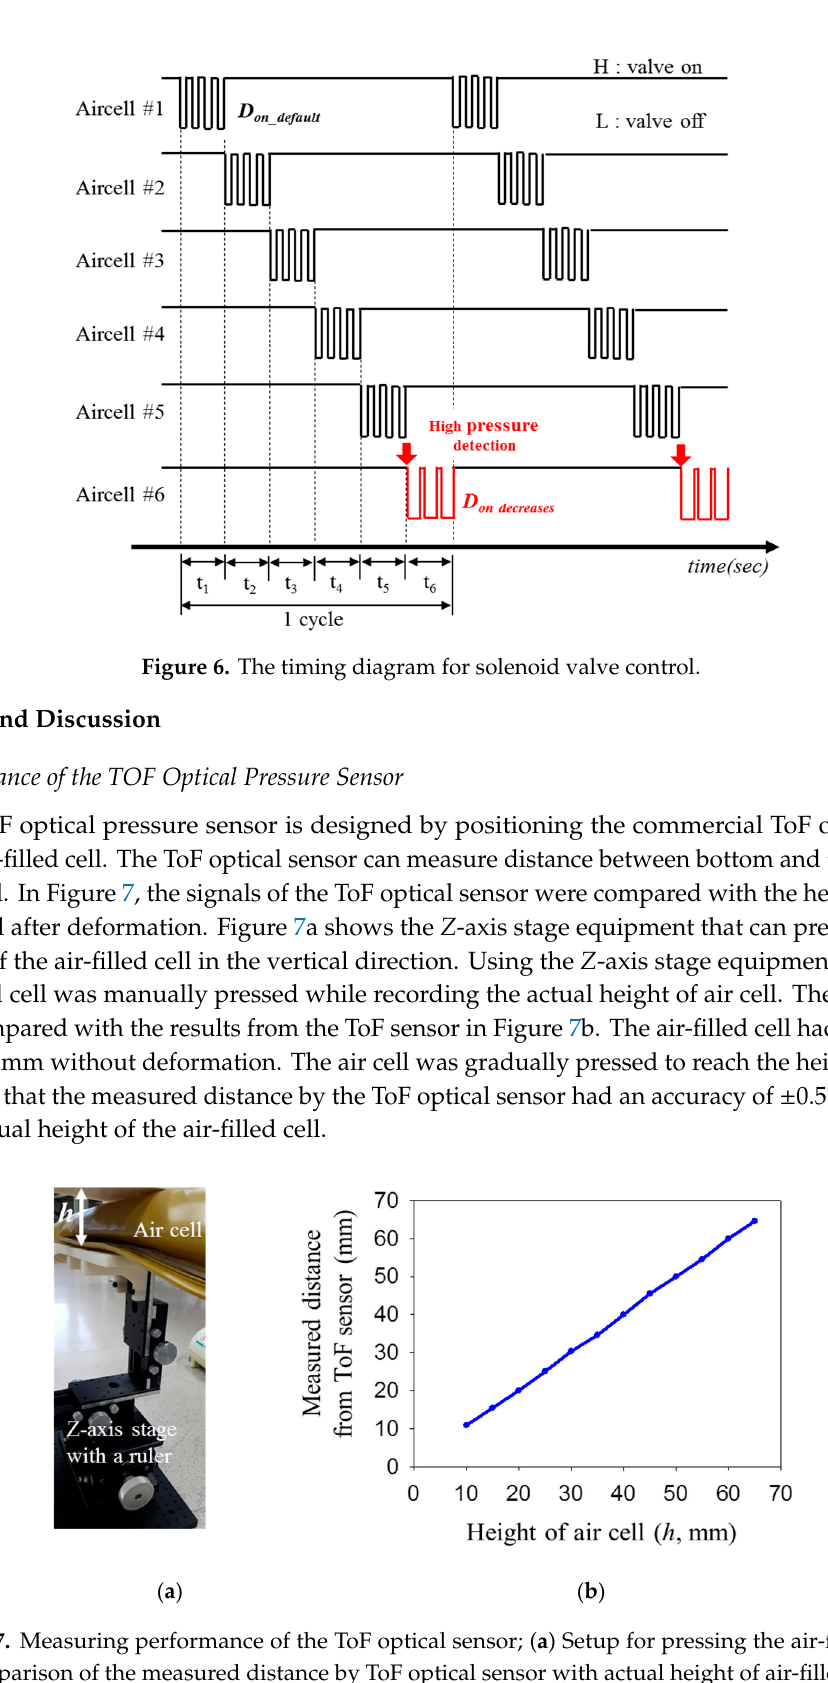
Figure 5. Pictures of the 3-way solenoid valves and a control board.